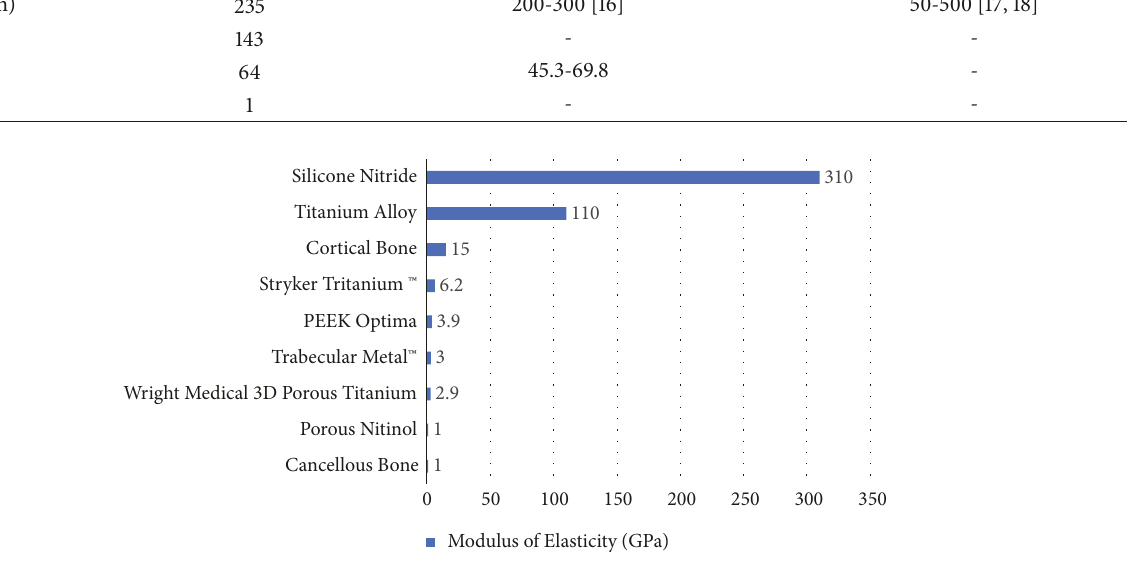
Figure 3: A comparison of elasticity moduli for commercially available biomaterials and cortical bone.